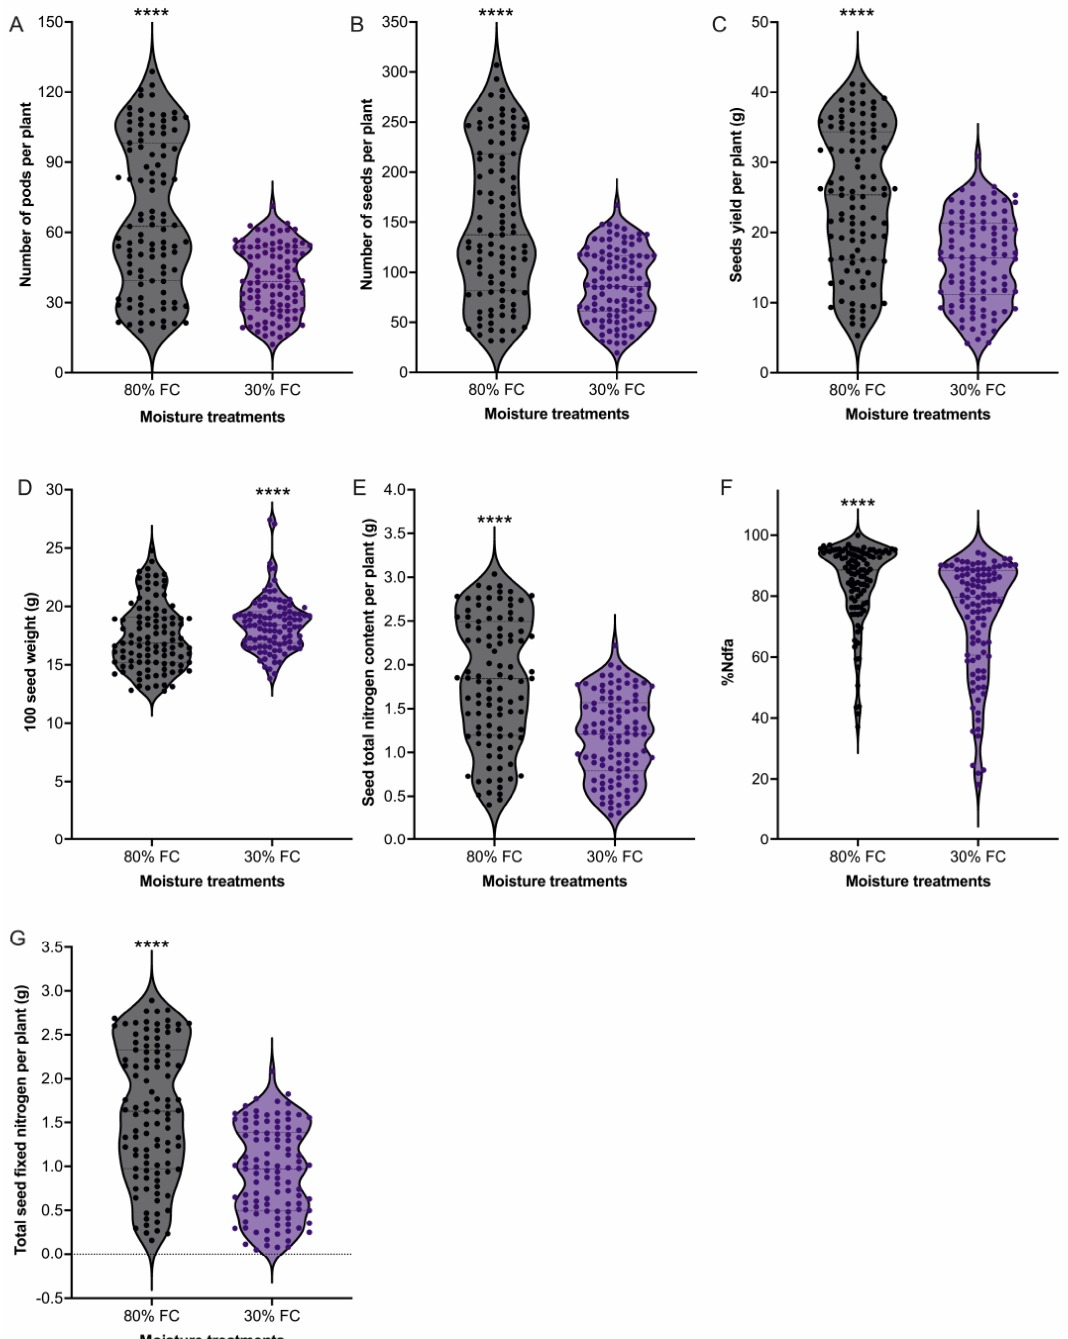
Figure 1. Distribution of yield- and SNF-related traits under well-watered and drought conditions in different soybean cultivars. ( A ) Number of pods per plant. ( B ) Number of seeds per plant. ( C ) Seed yield per plant. ( D ) 100-seed weight. ( E ) Seed total nitrogen content per plant. ( F ) Percentage nitrogen derived from the atmosphere (%Ndfa). ( G ) Total seed nitrogen fixed per plant. Each data point represents the mean value of a single cultivar. The asterisks (****) indicate significant differences between the 80% field capacity (FC) and 30% FC at p < 0.0001.